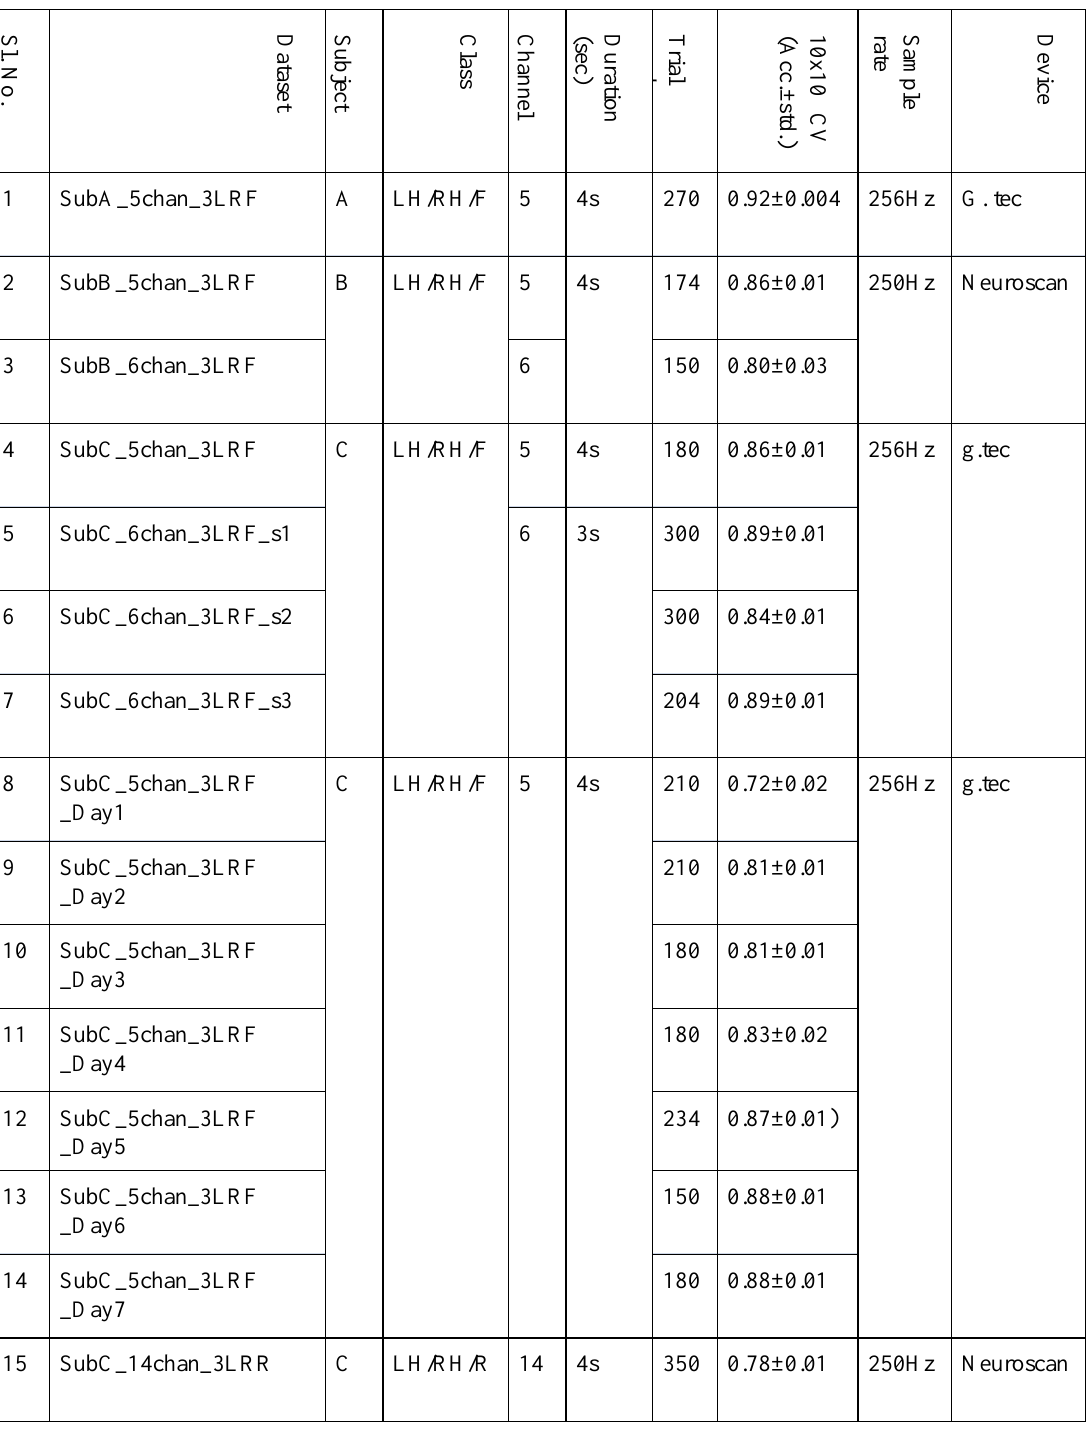
Table 1: The detailed information of three class